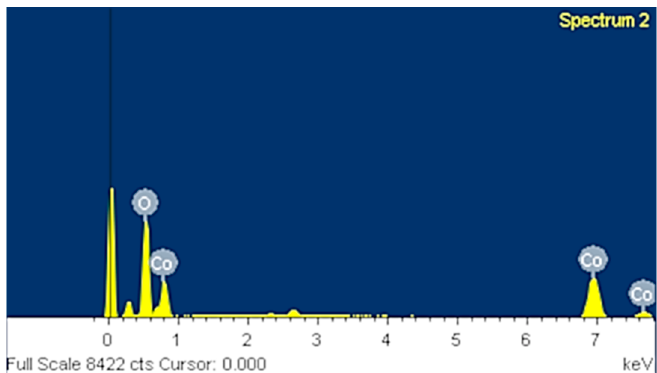
Figure 5. Elemental analysis (EDX) spectrum of the electrodeposited Co(OH) 2 (initial signals attributed to carbon tape used in the analysis).